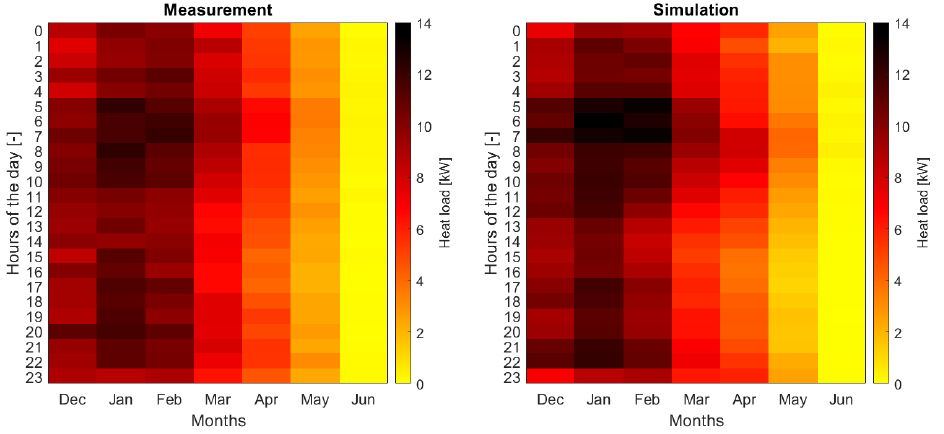
Figure 17. Measured ( left ) and simulated ( right ) mean space heating demand for the hours of the day of all